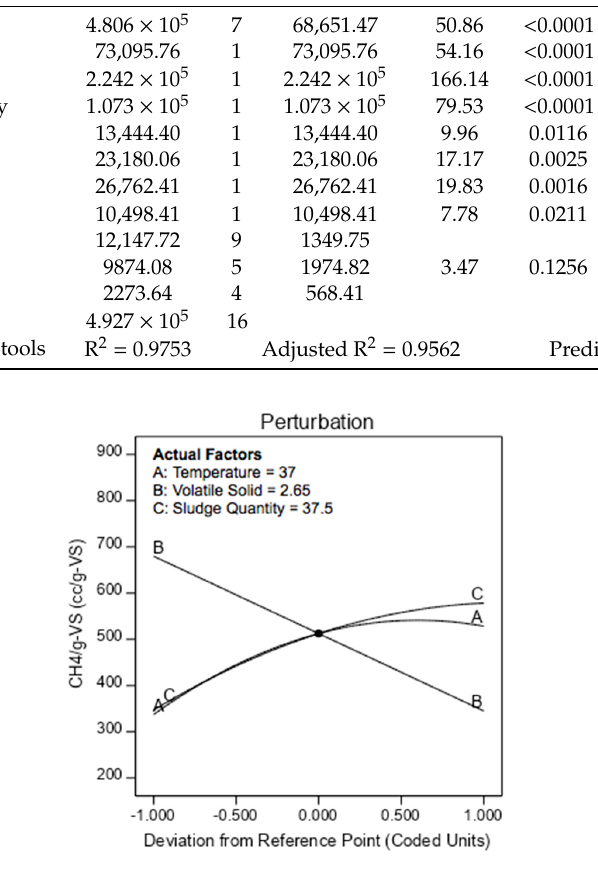
Figure 15. Perturbation plot showing the effect of all factors on the CH 4 g –1 -VS.